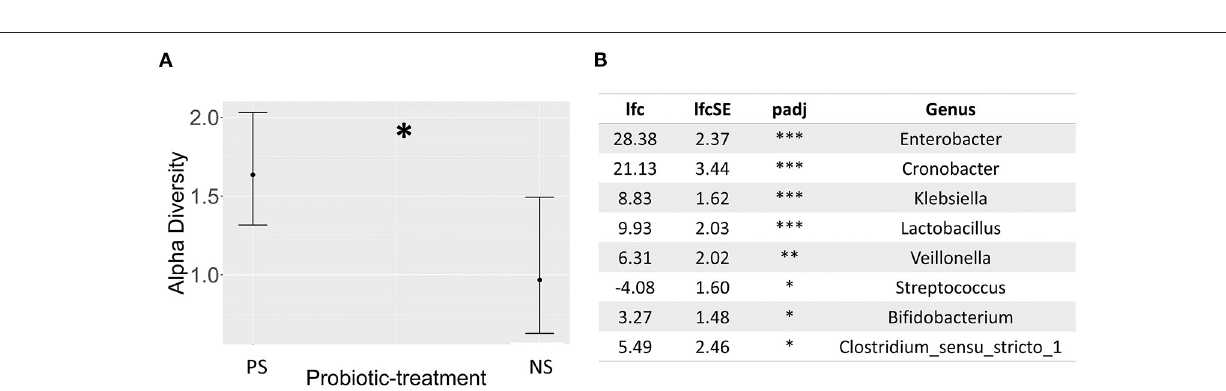
FIGURE 2 | (A) Dot whisker plot of the estimates for the probiotic-treatment covariate resulting from a generalized linear mixed effects regression model, exploring the effect of several known microbiome covariates on the Shannon diversity index derived from 16S rRNA short amplicon sequencing, and based on ASVs, (B) Table describing significantly differentially abundant taxa between probiotic-treated (base-level) and non-treated infants, using 16S rRNA short amplicon sequencing, as determined by DESeq2 analysis, based on data transformed through DESeq2’s variance stabilizing transformation. Annotation for probiotic-supplemented, PS; non-supplemented, NS; p-adj: adjusted p -value; lfc, log2-fold change; lfcSE, log2-fold change standard error; NT. P < 0.05 = *, P < 0.01 = **, P < 0.001 = ***. Sample sizes; probiotic supplemented = 63, and non-supplemented =